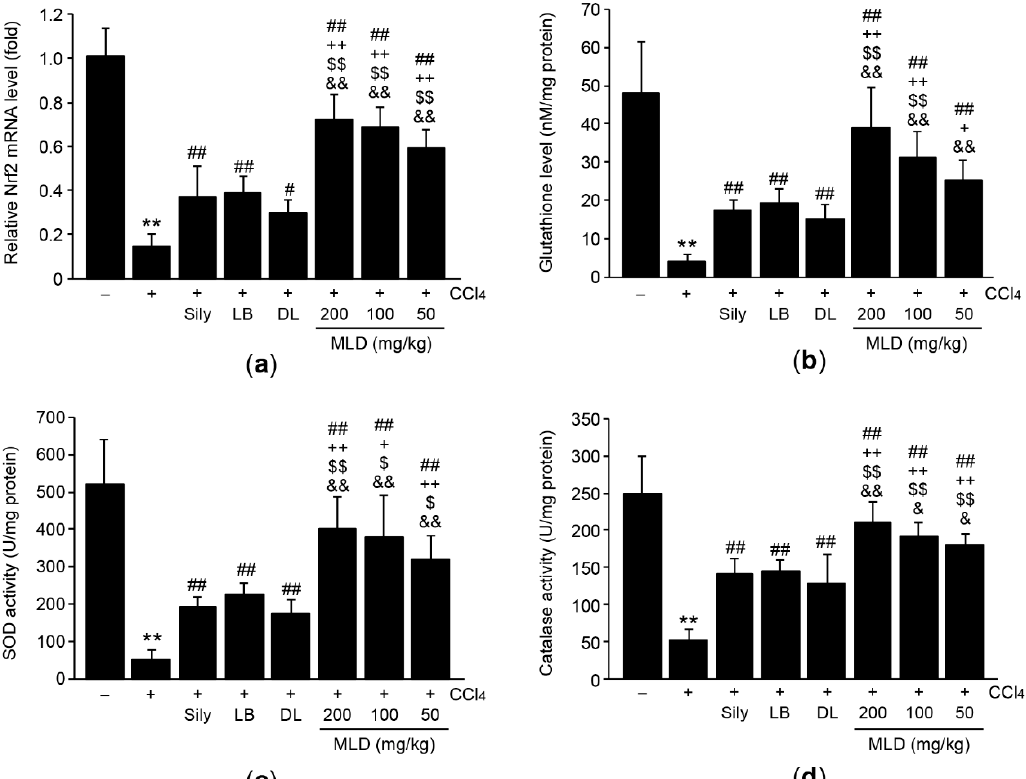
Figure 5. MLD increases antioxidant activities in CCl 4 -treated mice. Effects of MLD on Nrf2 mRNA levels ( a ), glutathione levels ( b ), SOD activity ( c ), and catalase activity ( d ) in hepatic tissues. All values are expressed as mean ± SD of ten mice. ** p < 0.01 between the vehicle and CCl 4 groups; ## p < 0.01, # p < 0.05 versus CCl 4 -injected mice; ++ p < 0.01, + p < 0.05 between Sily- and MLD-treated mice; $$ p < 0.01, $ p < 0.05 between LB- and MLD-treated mice; && p < 0.01, & p < 0.05 between DL- and MLD-treated mice.